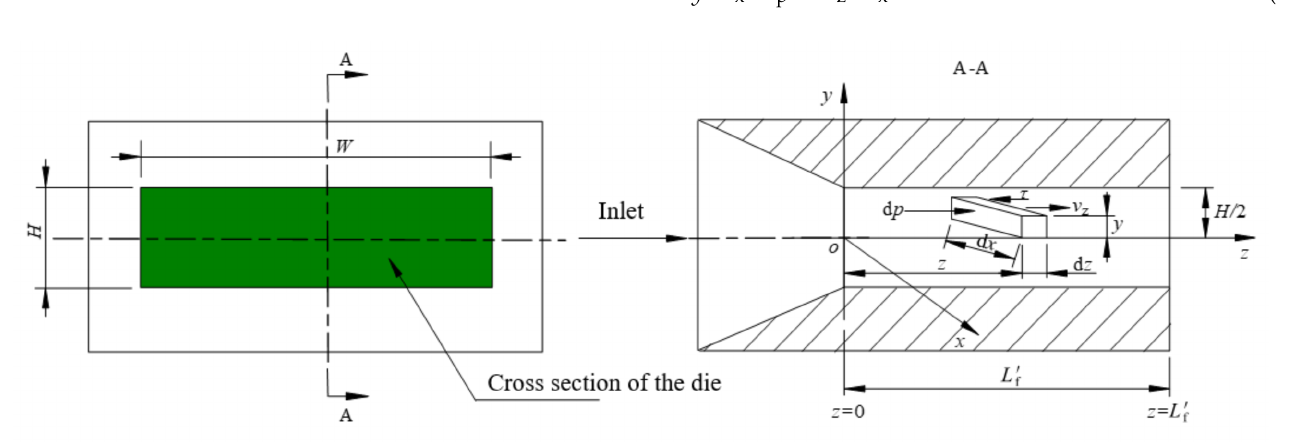
Figure 4. The flow channel structure of slit-shaped